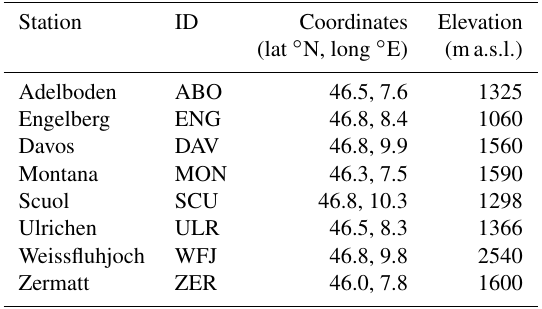
Table 1. Summary of case